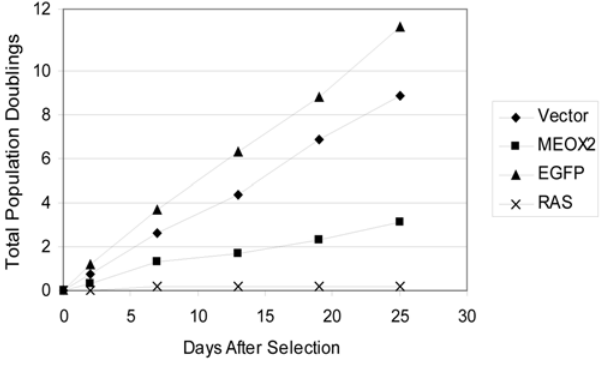
Figure 4. MEOX2 reduces proliferative capacity of primary human fibroblasts. Early passage WI38 fibroblasts were infected with retroviral particles expressing the indicated cDNAs, selected on puromycin, and assessed for proliferative capacity by periodic trypsinization and cell counting.